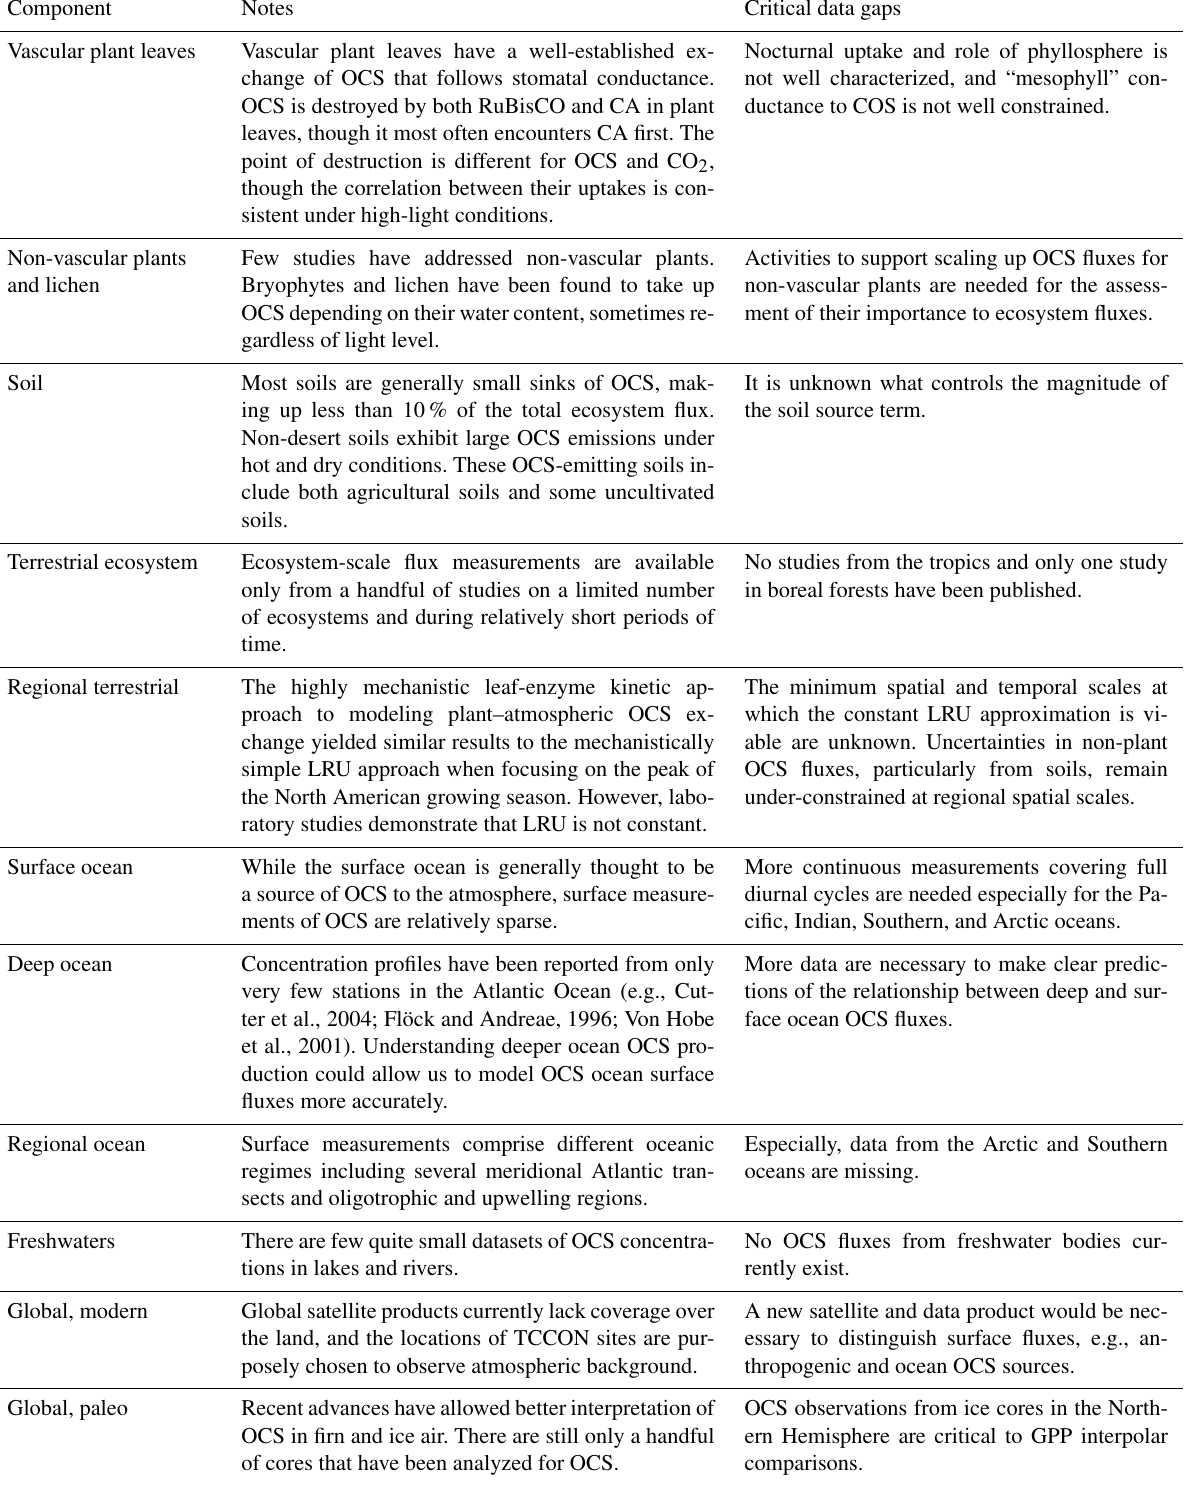
Table 6. Components of the OCS budget and data